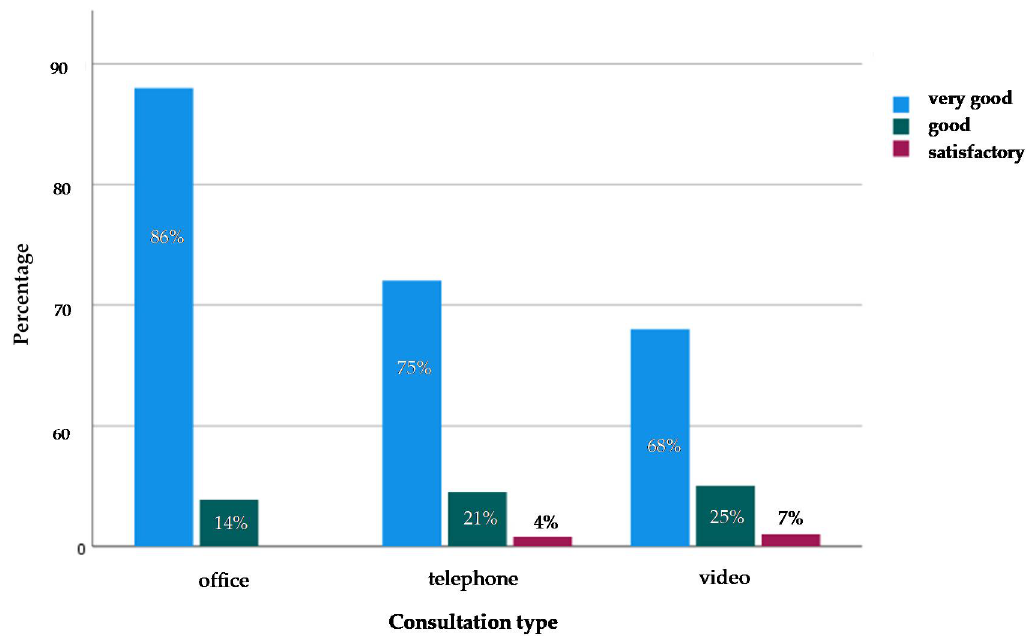
Figure 1. Satisfaction with the type of contact. Percentages (%) as cumulative values per category . Within the subject area “assessment of therapeutic contact”, the item “global judg- ment” had a mean of 1.3 (SD = 0.5) in the overall group. In subgroup office, the mean value ± SD of this item was 1.1 ± 0.3, in the telephone subgroup, 1.3 ± 0.6 and in the video sub- group, 1.4 ± 0.6 (F(2,97) = 2.28, p = 0.11, Table 2). All other items assessed were in the range of M = 1.1 to 1.6, both for the overall group and within the three subgroups, i.e., all were rated between very good and good. No significant differences between subgroups were observed (Table 2). Table 2. Assessment of therapeutic contact, therapeutic relationship, and hurdles in different counseling formats. All Contacts